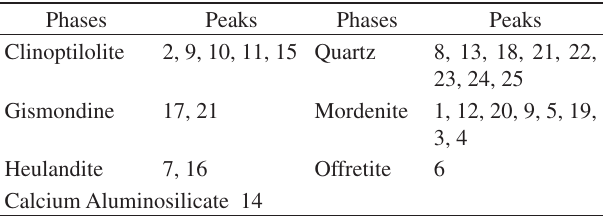
Table 3. Influence of the Nalco 8589 as function of the residual turbidity of the supernatant for the systems (Ba-FZ + H